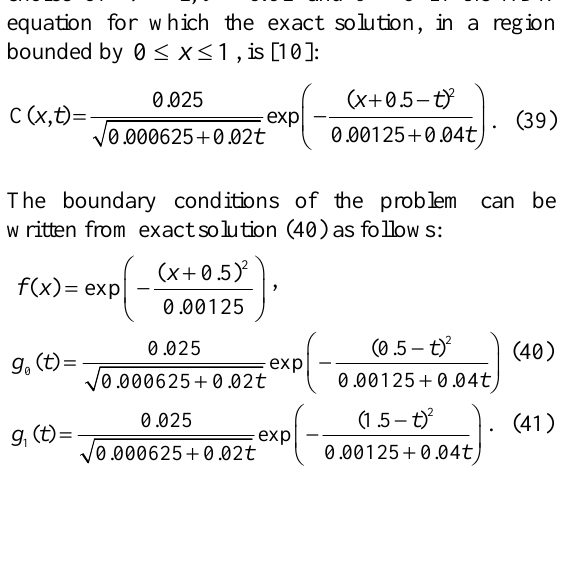
Table 4 . Comparison of the peak value for (cid:10) (cid:2) 0.01 , (cid:18)(cid:19) (cid:2) 1 , (cid:24) (cid:2) 0.5 and (cid:14) (cid:2) 1 in Problem